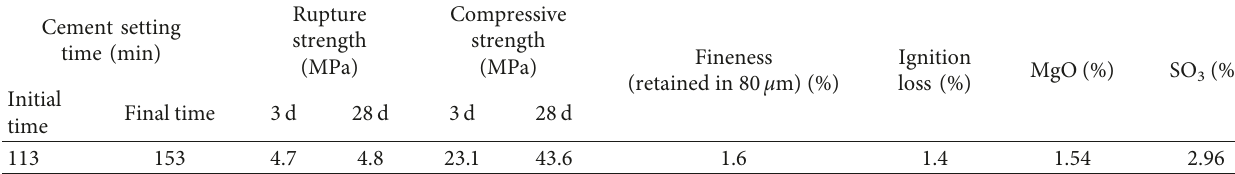
Table 1: P.O 42.5R ordinary cement indexes.